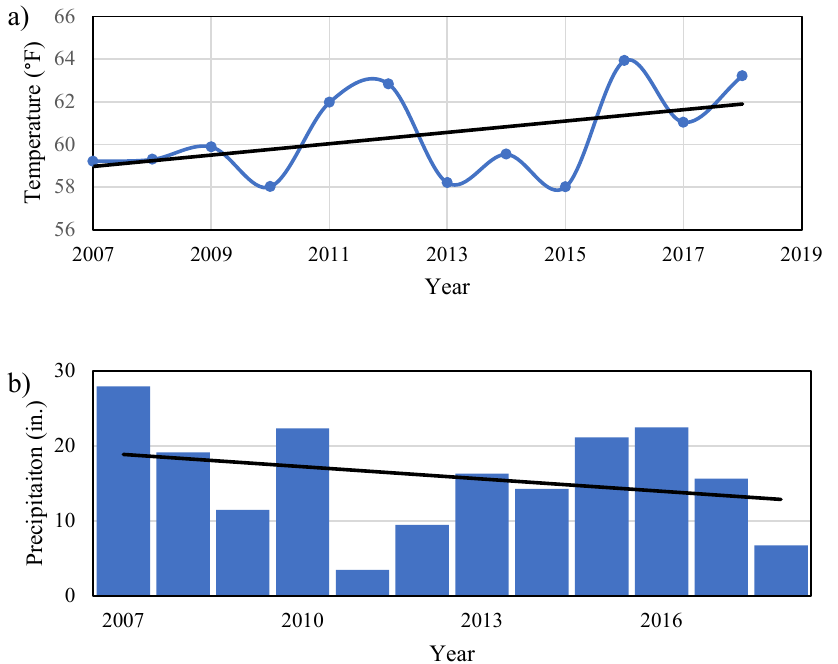
Figure 2. ( a ) Annual average temperature (trend equation: y = 0.27x − 474.57) and ( b ) annual total precipitation (trend equation: y = − 0.55x + 1112.80) in Lamesa, TX according to US Climate Data from 2007 to 2018.